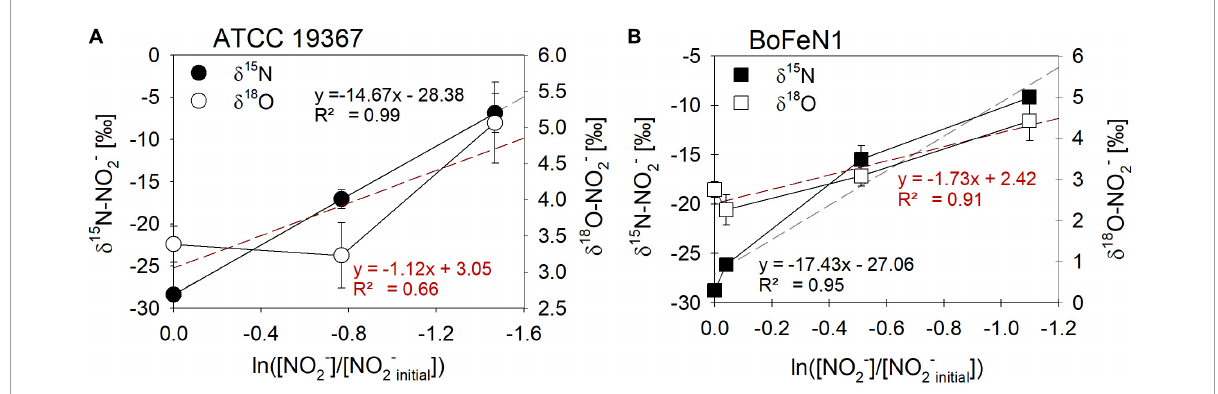
FIGURE10 Rayleigh plots for δ 15 N- ( (cid:108) , (cid:3) ) and δ 18 O- ( (cid:13) , (cid:3) ) NO 2 − values for the control denitrifier Paracoccus denitrificans strain ATCC 19367 (A) and Acidovorax sp. strain BoFeN1 (B) grown mixotrophically in the presence of Fe(II) and acetate. Equations and dotted lines in black represent the linear regressions for δ 15 N, whereas red lines represent δ 18 O. Note that for δ values, different scales apply. Error bars represent standard error calculated from biological replicates [ n = 4 (A) , 3 (B) ].